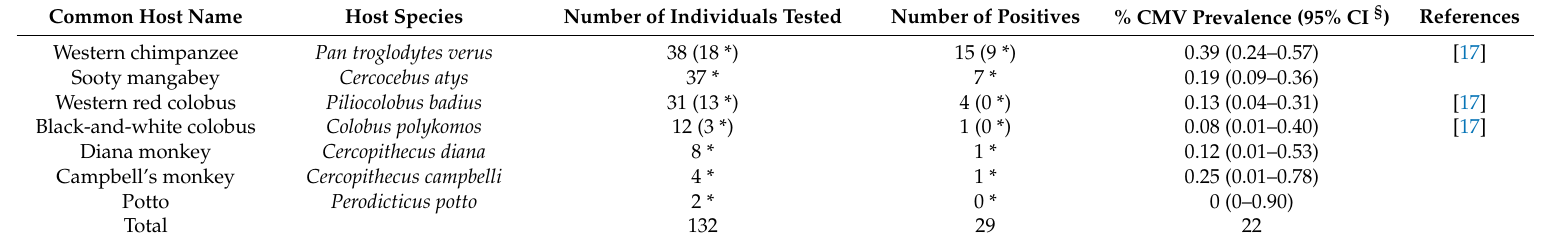
Table 1. Cytomegalovirus (CMV) prevalence in nonhuman primates in Taï National Park, C ô te d’Ivoire.